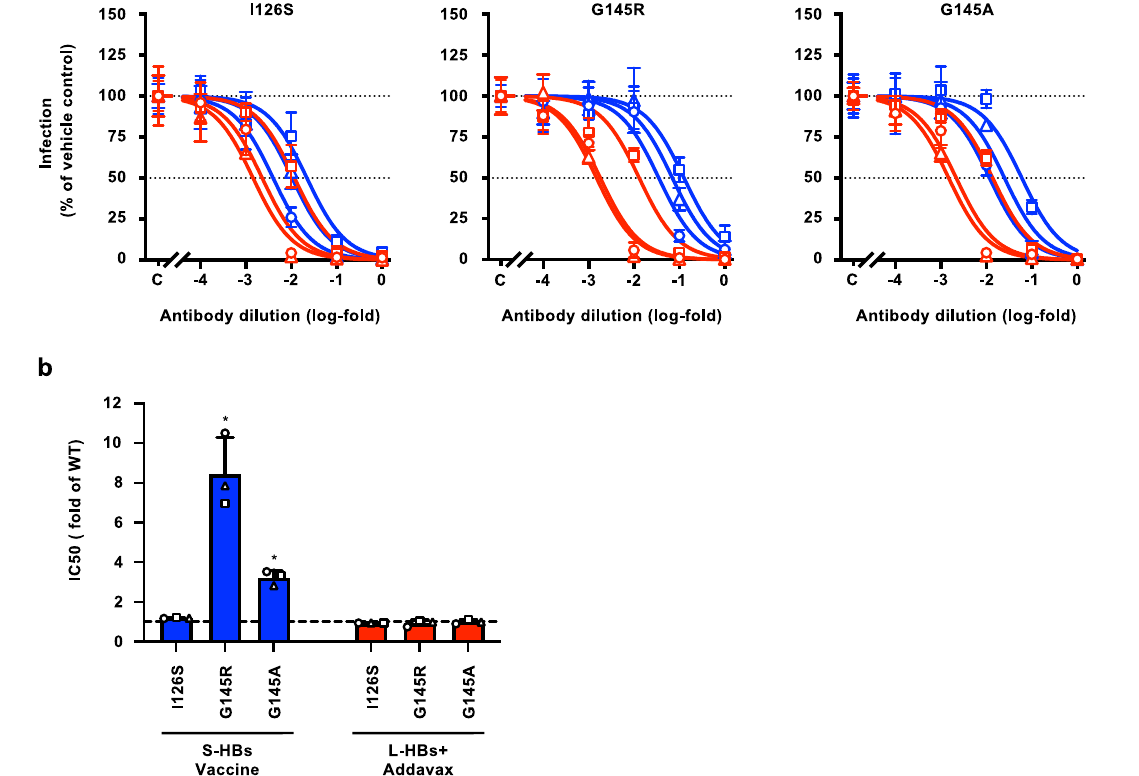
Fig.4|NeutralizingactivitiesagainstHBVwithVEM.a Theneutralizingactivities of induced antibodies to HBV with VEMs were evaluated by the HBV/NL infection system.TheHBV/NLstrainswithVEMs,HBV/NL-I126S,-G145R,and-G145A(20GEq/ cell)weremixedwithseriallydilutedantibodiesfromrhesusmacaquesimmunized with S-HBs vaccine (blue) and L-HBs+Addavax (red) for 1h at 37°C and used to infect G2/NT18-C cells. The infection ef fi ciencies were assessed by measuring the